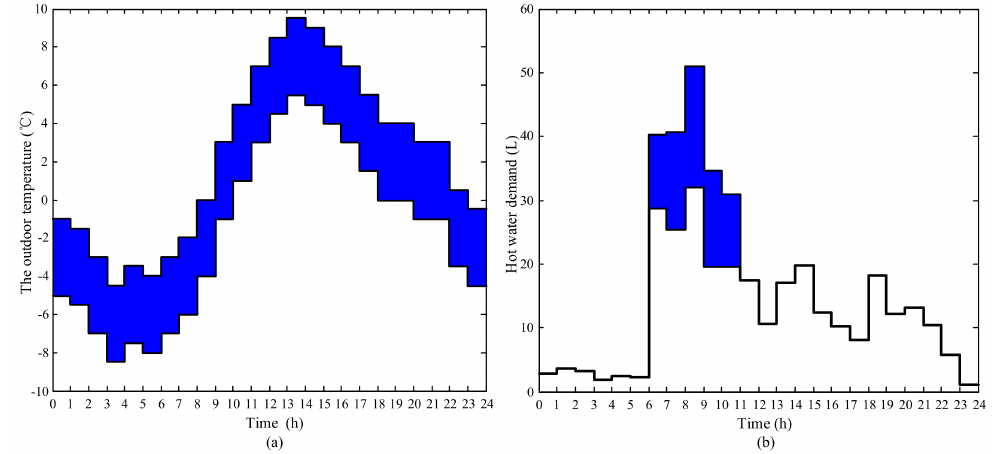
Figure 2. ( a ) The uncertainty set of the outdoor temperature for the next day; and ( b ) the uncertainty set of the hot water demand for the next day.